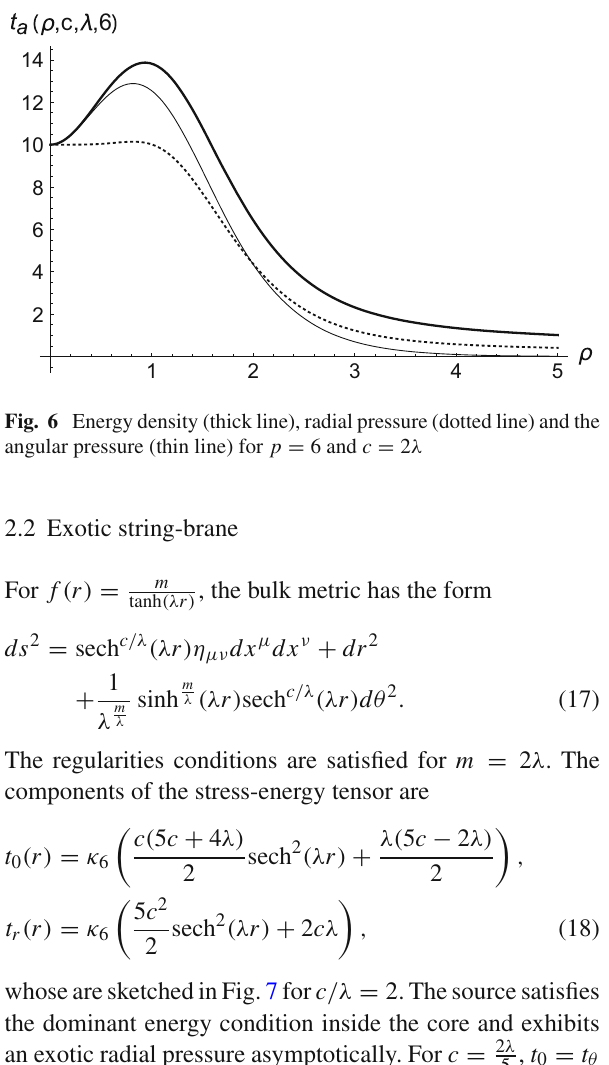
Fig. 5 Energy density (thick line), radial pressure (thin line) and the angular pressure (dotted line) for p = 1 and c /λ = 2